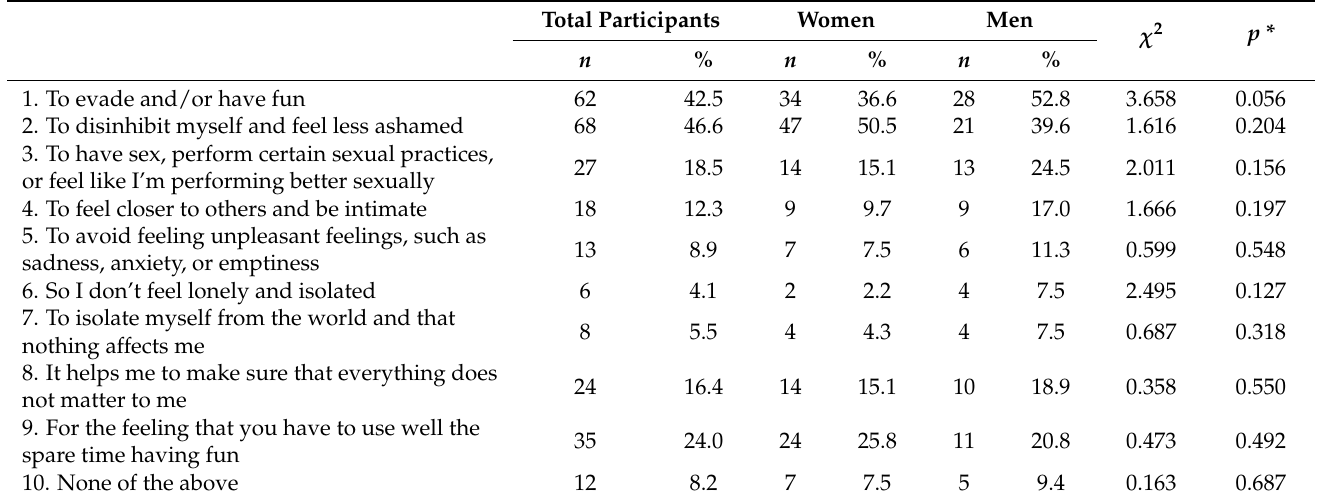
Table 4. Main Motivations for Practicing SDU.